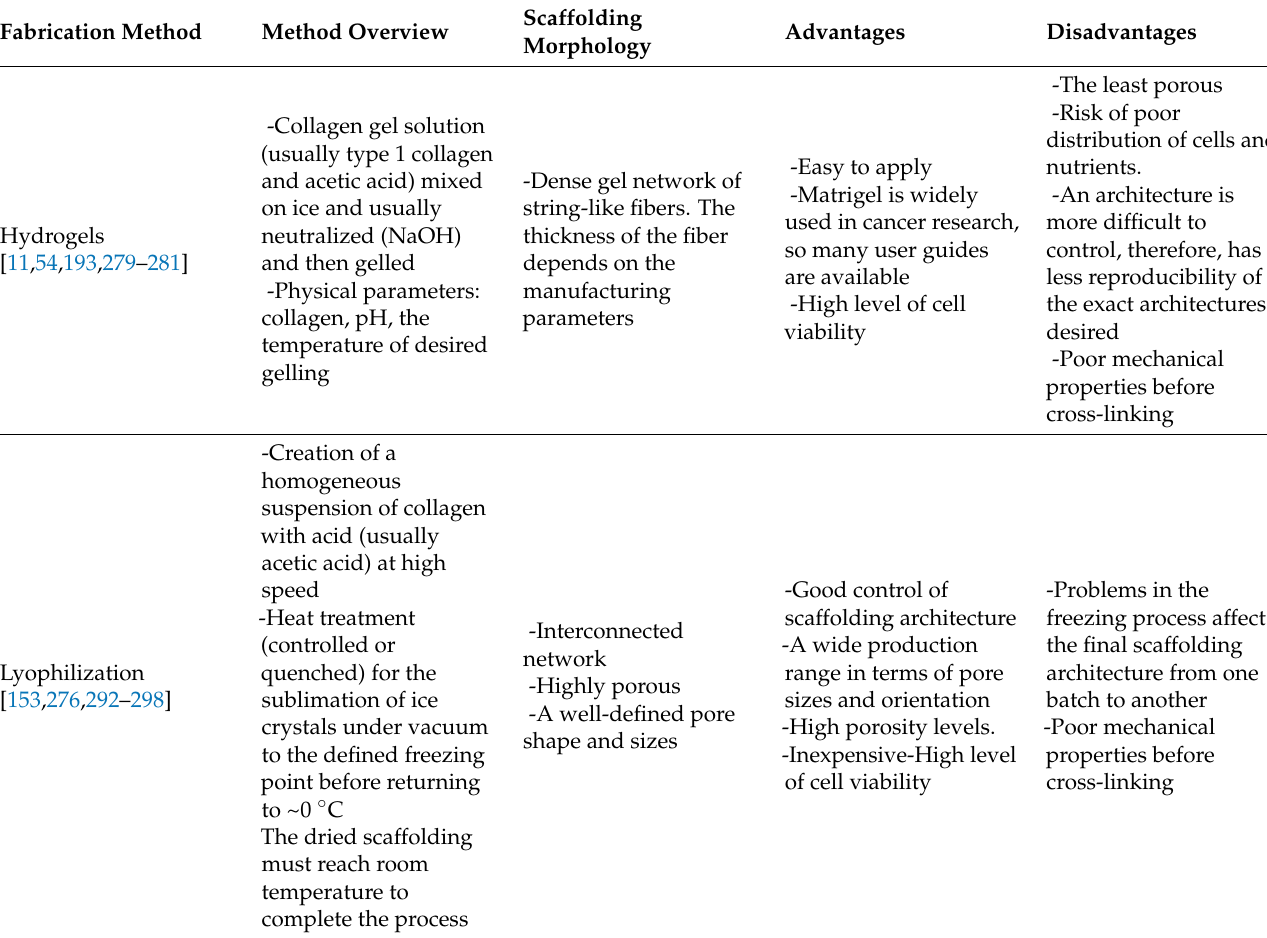
Table 5. Comparison of different synthetic strategies of 3D